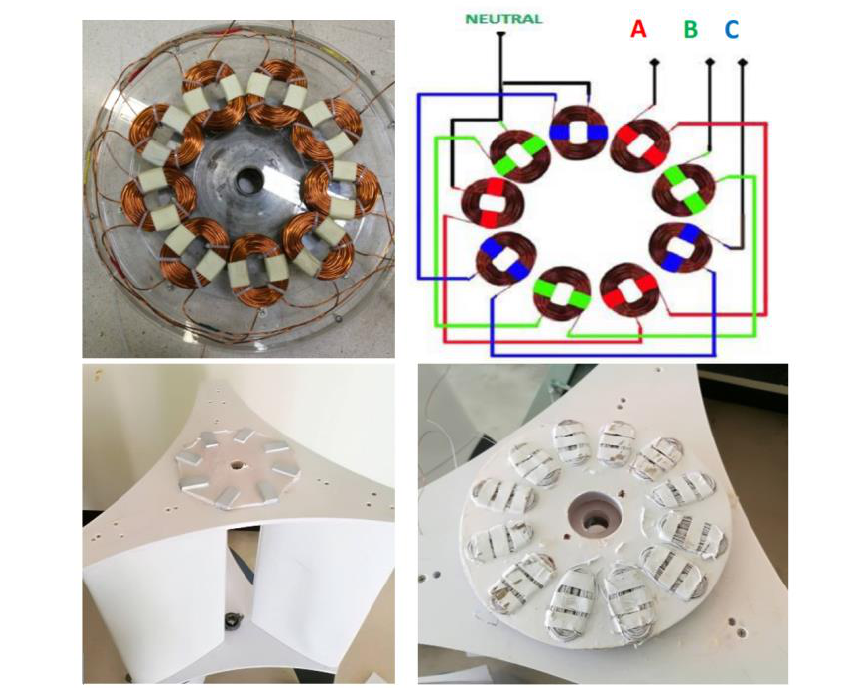
Figure 10. Electrical generator in wind turbine with S-D rotor: Three-phase electric power (A, B and C phase)